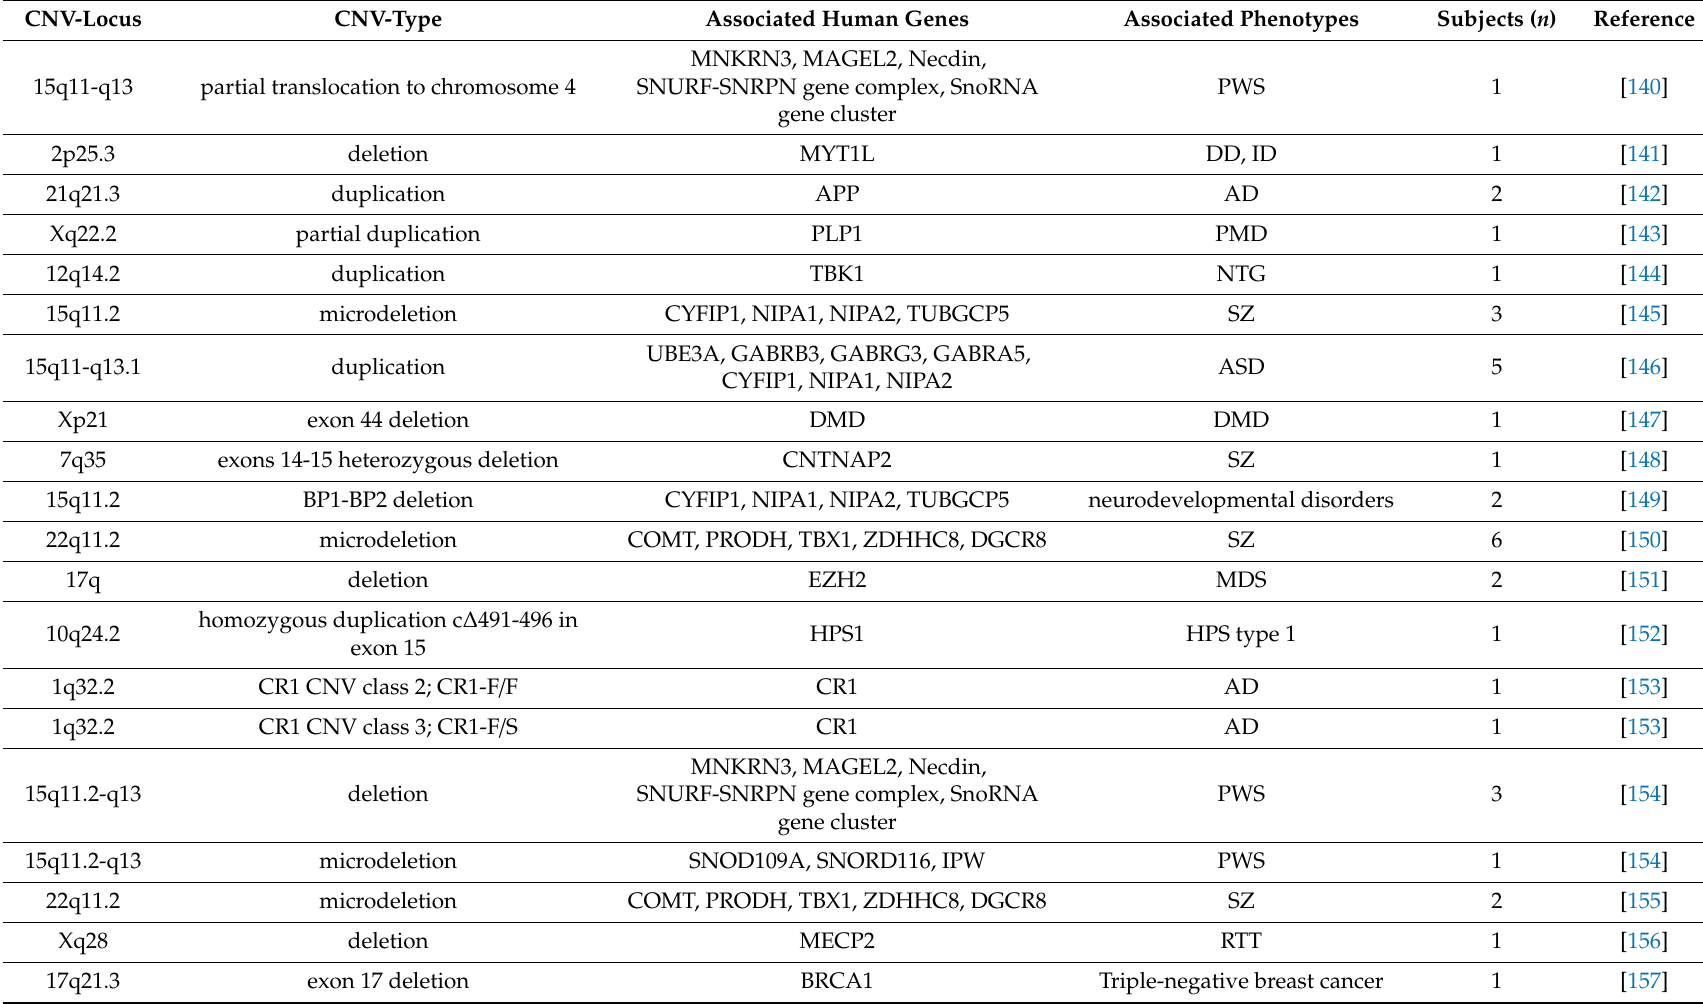
Table 1. Induced pluripotent stem cell (iPSC) lines generated from CNV-carrier patients published in the last 10